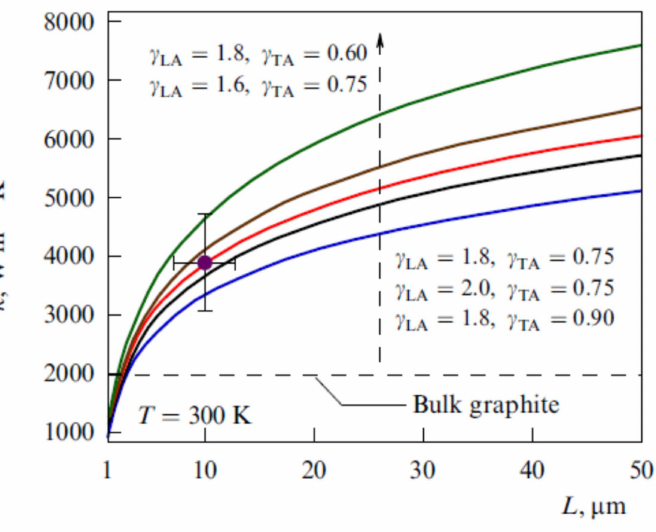
Figure 8. Dependences of the room temperature thermal conductivity k of a rectangular defectless graphene sheet on size L calculated for different values of the Grüneisen parameter for longitudinal γ LA and transverse γ TA vibrational modes [65].